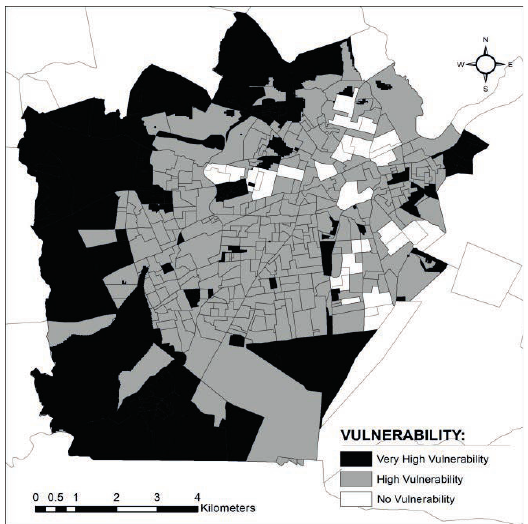
Fig. 4 Vulnerability (increased by hydraulic